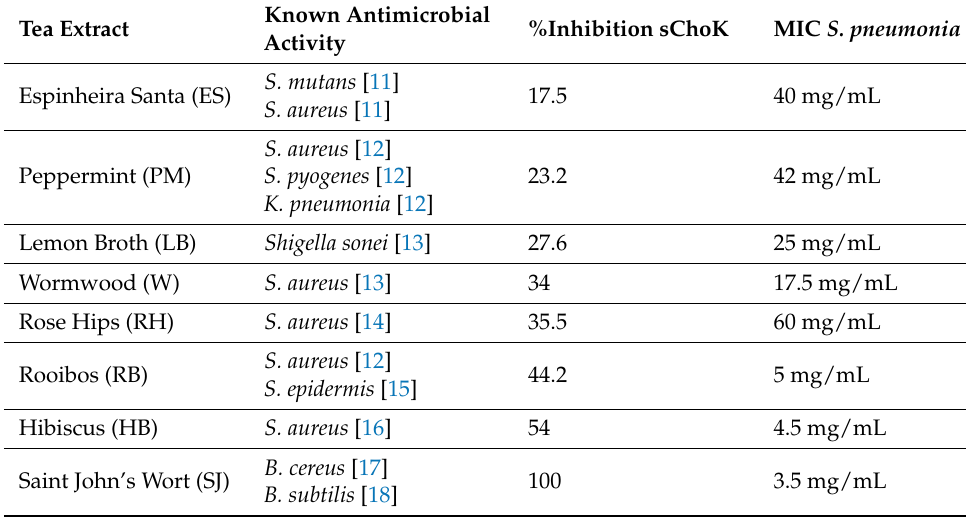
Table 1. Tea extracts were tested for inhibitory activity against the sChoK enzyme and against S. pneumoniae growth. The tea extracts are ranked in order of increasing inhibitory strength against the sChoK enzyme, the strongest being Rooibos (RB), Hibiscus (HB) and Saint John’s Wort (SJ). Inhibitory strength was tested at a tea concentration of 7 mg/mL. All teas were also tested by serial dilution in broth cultures and by single dilution on Mueller–Hinton Plates (See Figure